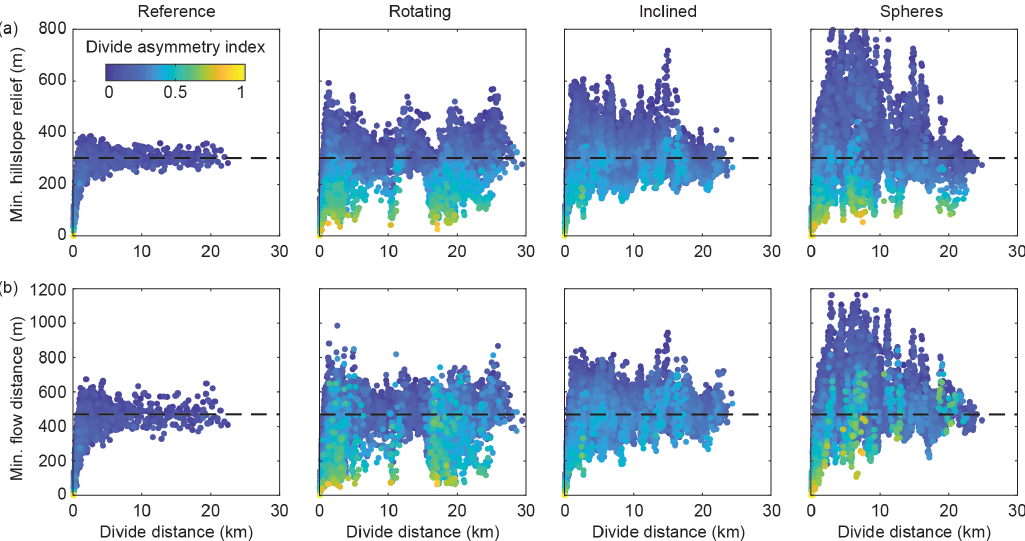
Figure 9. Minimum hillslope relief (a) and minimum flow distance (b) of all divide segments along the drainage divide network from the last 1Myr of the landscape evolution experiments Reference, Rotating, Inclined, and Spheres. Colors denote the divide asymmetry index (DAI). The black stippled line indicates the average values of minimum hillslope relief and minimum flow distance from the model Reference, measured between a divide distance of 10 and 20km.